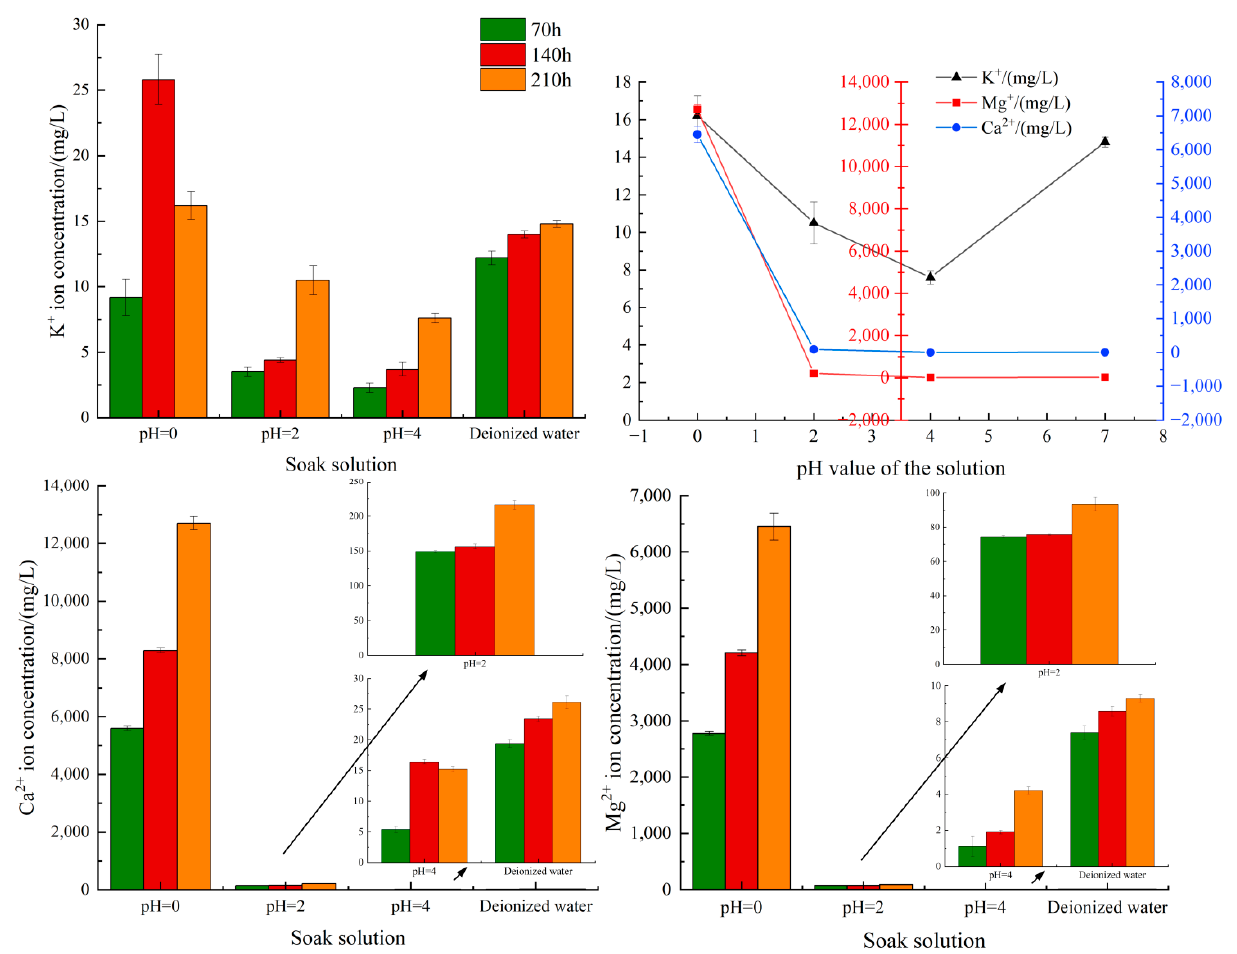
Figure 9. Concentrations of K + , Ca 2+ , and Mg 2+ in different solutions.